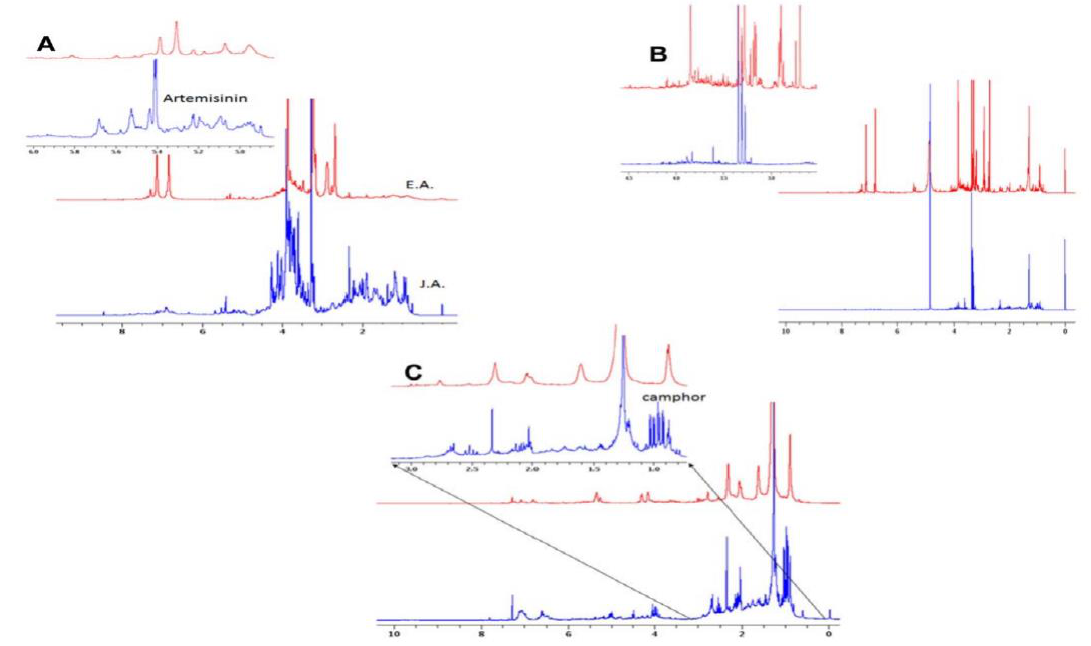
Figure 7. NMR analyses of the chemical compositions of the hexane–chloroform, methanol and water extracts of both EA and JA. The NMR spectrum of EA and JA water extracts ( a ). The NMR spectrum of EA and JA hexane–chloroform extracts ( b ). The NMR spectrum of the JA and EA methanol extracts ( c ). [43].